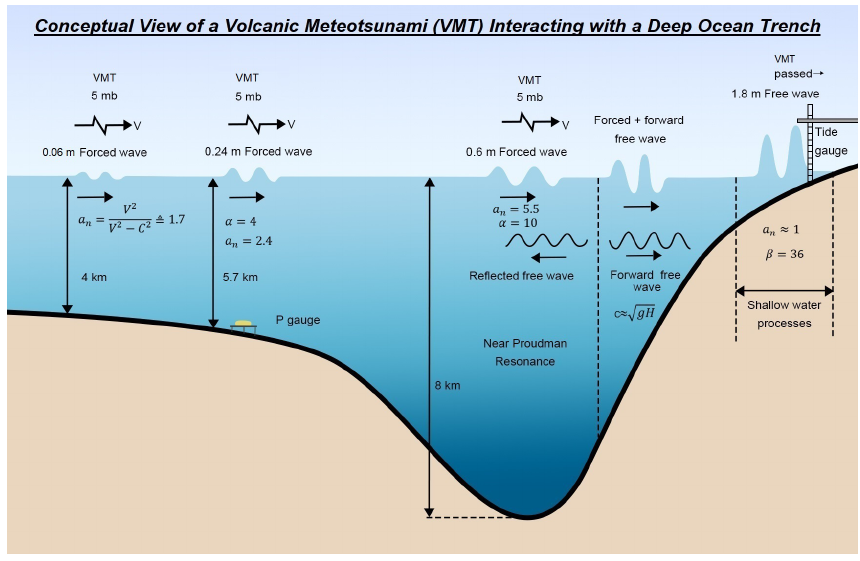
Figure 9. Conceptual view of amplification of a VMT, based on Tonga event observations. An initial shock wave amplitude of 5mb is amplified by Proudman resonance in the trench and again by shallow water processes, after reflection of a free wave by the steep topography landward of the trench. With β = 36, a 1.8m tsunami occurs at the tide gauge. A larger VMT would lead to a proportionally larger